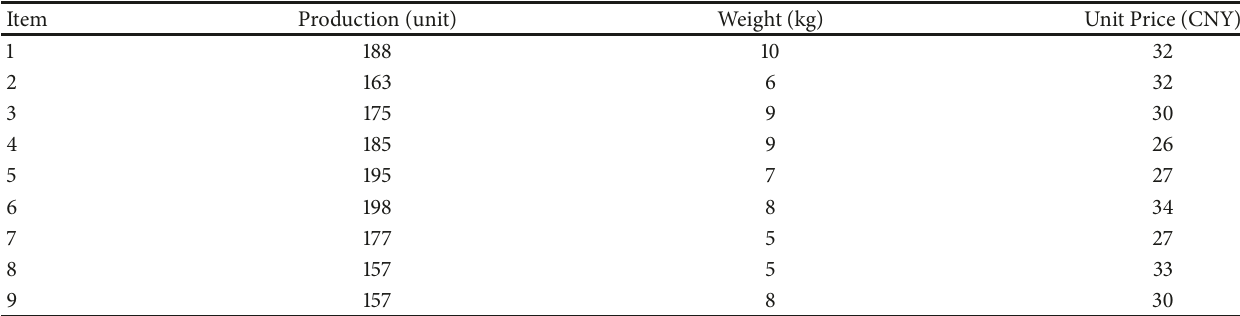
Table 2: Production, weight, and unit price of each downjackets.